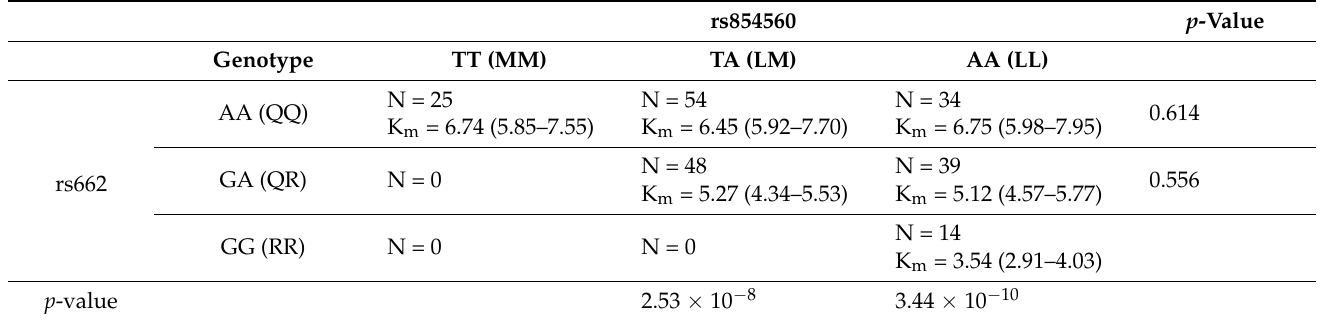
Table 2. Average K m values (in µ M) for each pair of genotypes of the PON1 SNPs rs662 and rs854560. Some pairs of genotypes were not present in any patient in our study (N = 0). A cell shows the number (N) of patients with a certain pair of genotypes and the median (interquartile range) for K m . rs854560